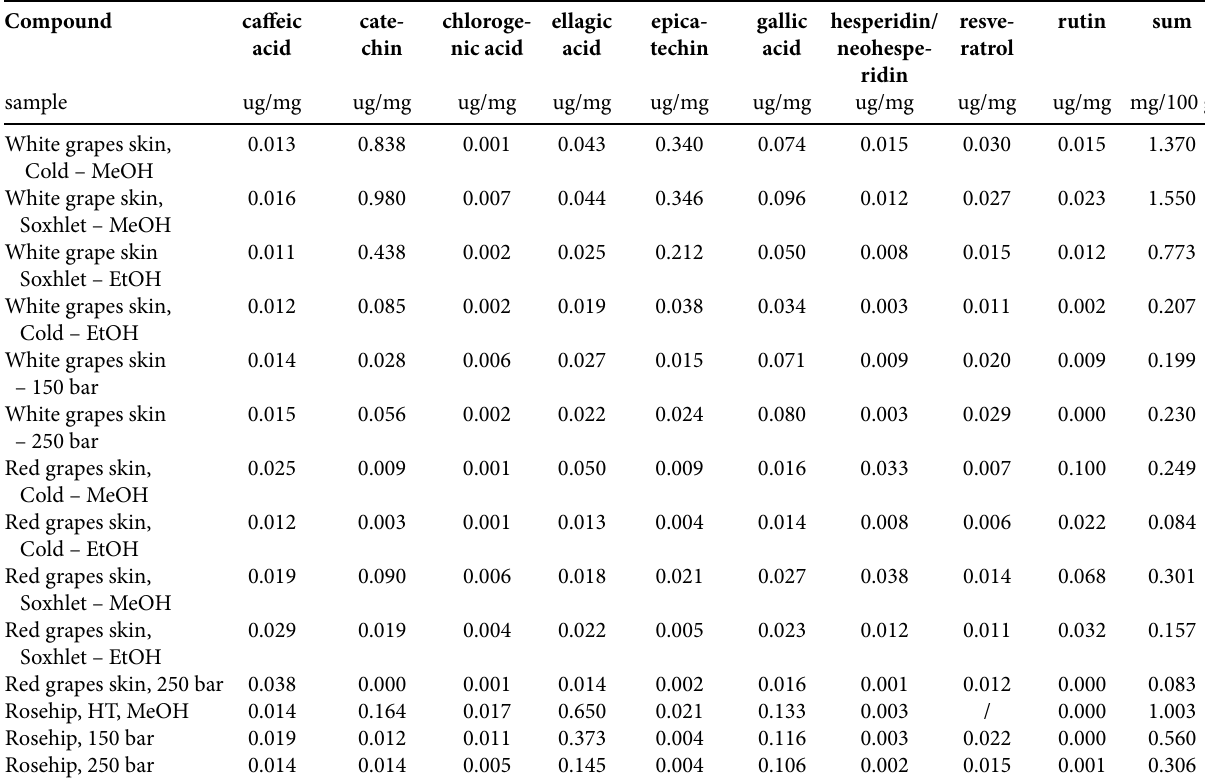
Table 1: Content of phenolic compounds in the extracts of white and red grape skin and rosehip at different extraction conditions.